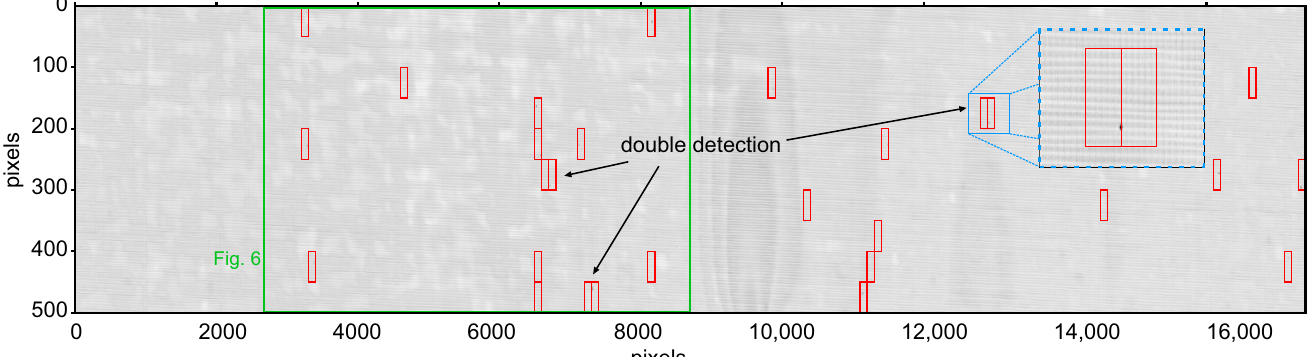
Figure 9. Illustration of the outcome of the automated defect recognition on the whole measured press sleeve area with the previously trained ML anomaly detection model. The red rectangles mark the image segments labeled as outliers (defects) by the algorithm. Double detection occurs when the defects extend from one image segment to an adjacent one (see magnification). The large green rectangle marks the section of the sleeve, which was displayed before in Figure 6. In total, 24 out of 26 manually labeled defects are correctly recognized as outliers, yielding a detection accuracy of